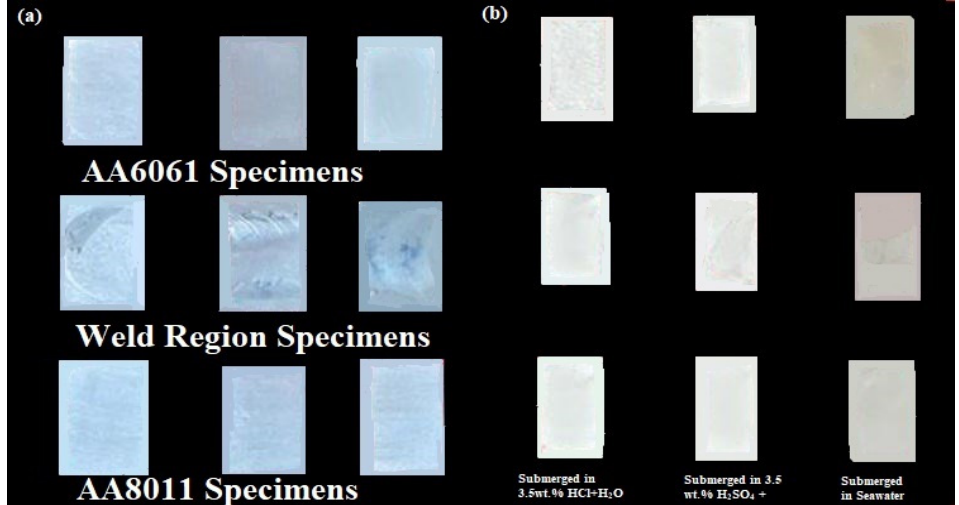
Figure 5. Corrosion test specimens: ( a ) before corrosion test; ( b ) after corrosion test.